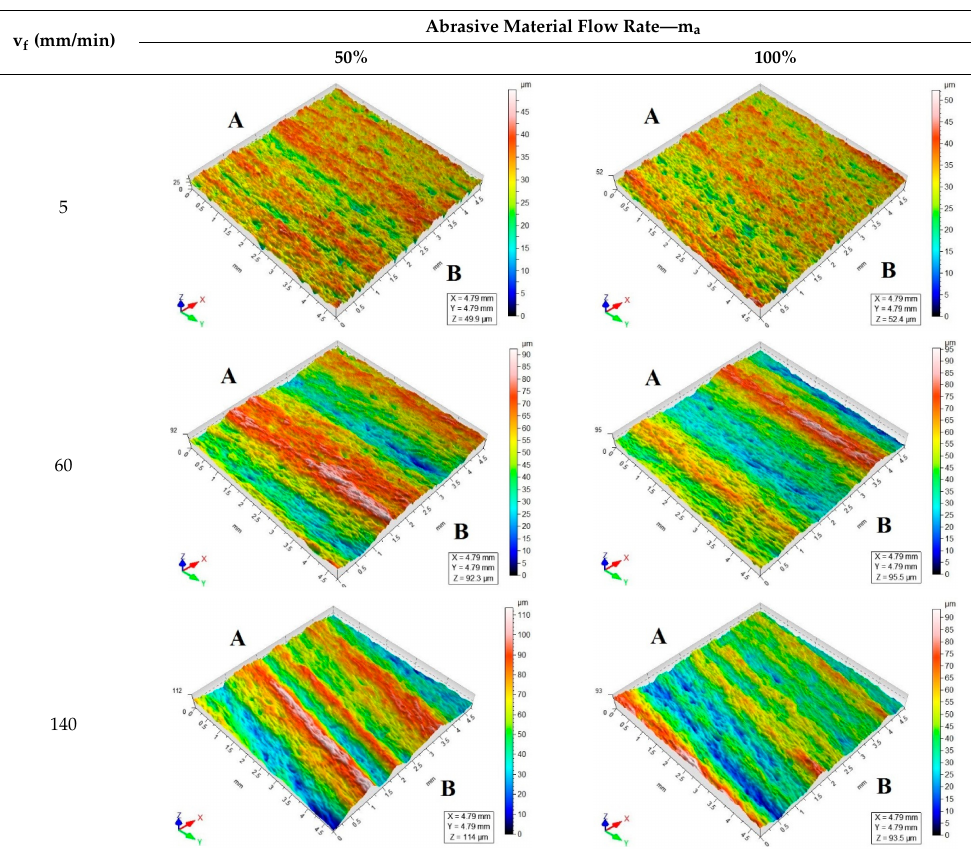
Table 3. Selected isometric images of AZ91D specimen surfaces after AWJM.